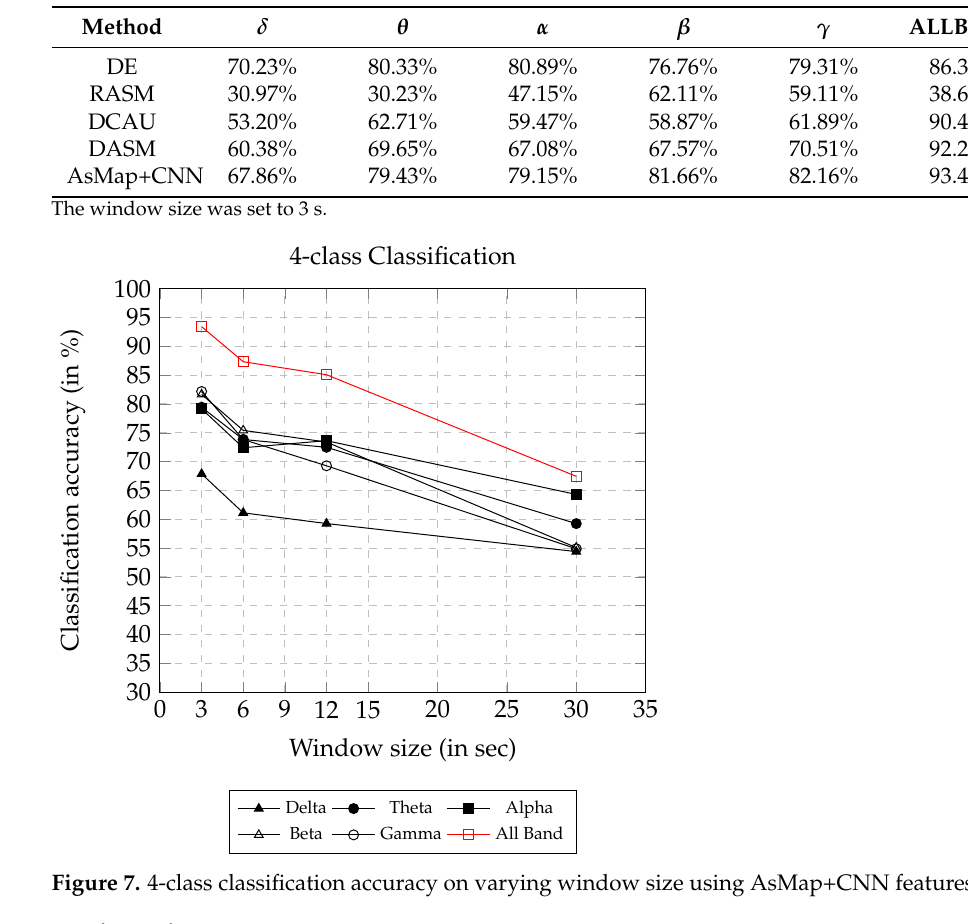
Table 4. Four-class classification accuracy obtained using different feature extraction techniques on frequency bands.